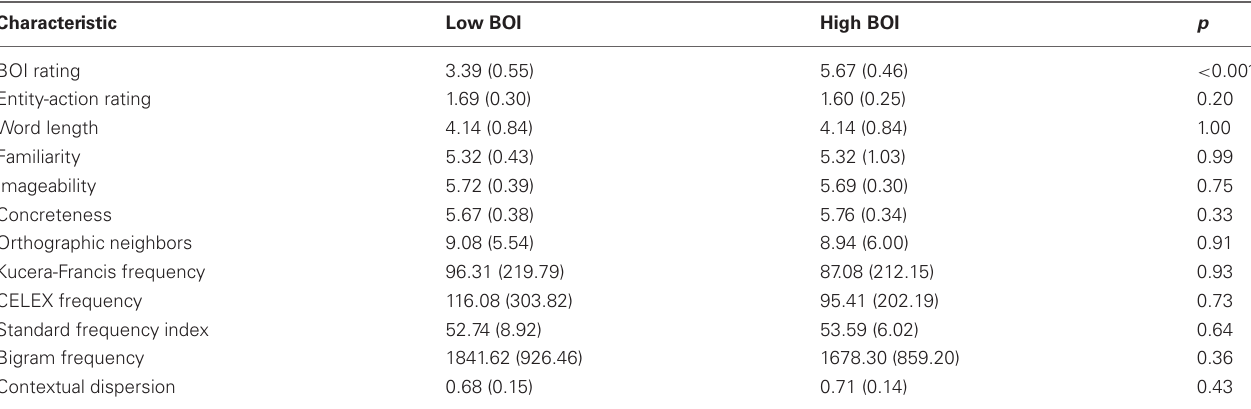
Table 2 | Mean (SD) characteristics of low-BOI and high-BOI word stimuli.